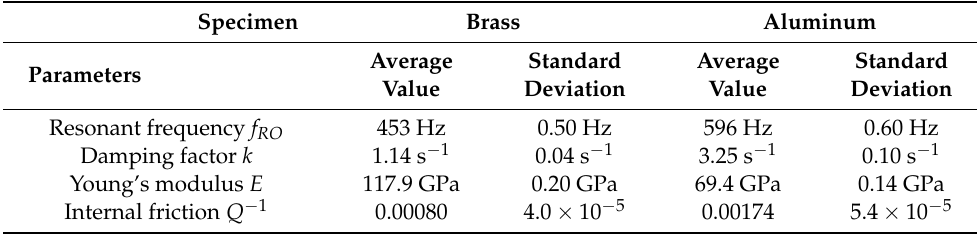
Table 1. Experimental measurement